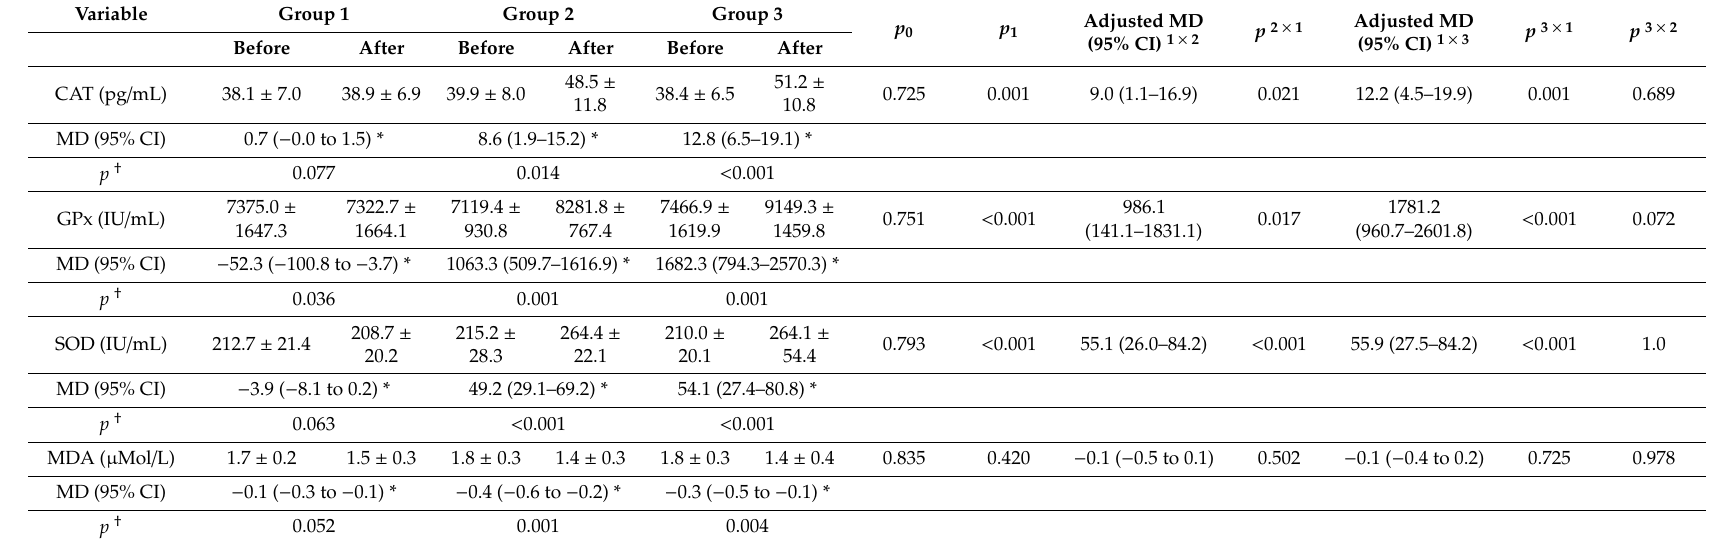
Table 4. Comparison of mean ± SD serum levels of CAT, GPx, SOD, and MDA in participants receiving CC, herbal mixture, and CC along with herbal mixture. Variable Group 1 After Before After Before